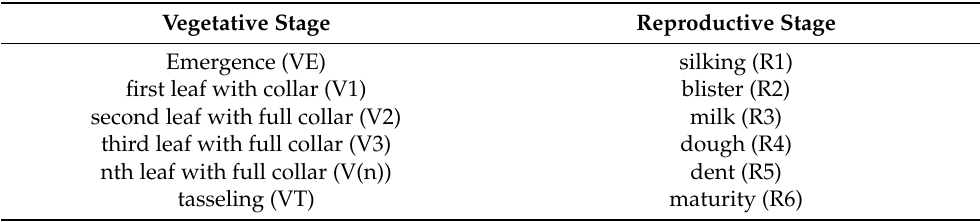
Table 2. Growth and development stages of maize. Reproduced with permission from